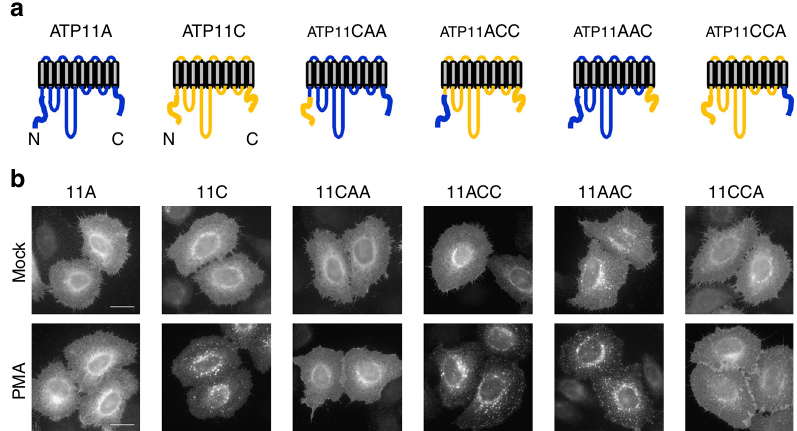
Fig. 4 C-terminus of ATP11C is indispensable for PMA-induced endocytosis. a Schematic structures of a chimeric construct of ATP11A and ATP11C proteins are shown. b HeLa cells were transiently co-transfected with expression vectors for FLAG-tagged CDC50A and HA-tagged ATP11A, ATP11C, ATP11CAA, ATP11ACC, ATP11AAC, or ATP11CCA. Cells were treated with vehicle alone (Mock) or 400 nM of PMA (PMA) for 15 min and fi xed. The fi xed cells were permeabilized and incubated with anti-HA antibody, followed by Cy3-conjugated anti-rat secondary antibody. Scale bars, 20 μ